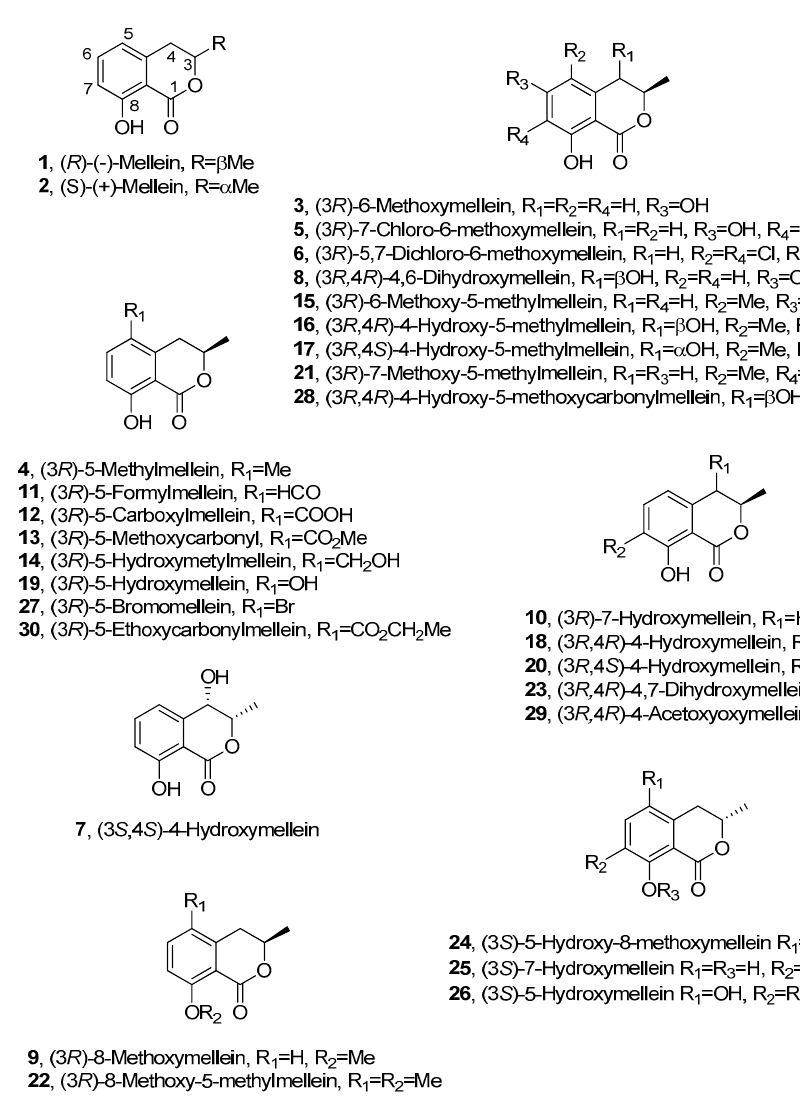
Figure 2. The structures of 1 - 30 .